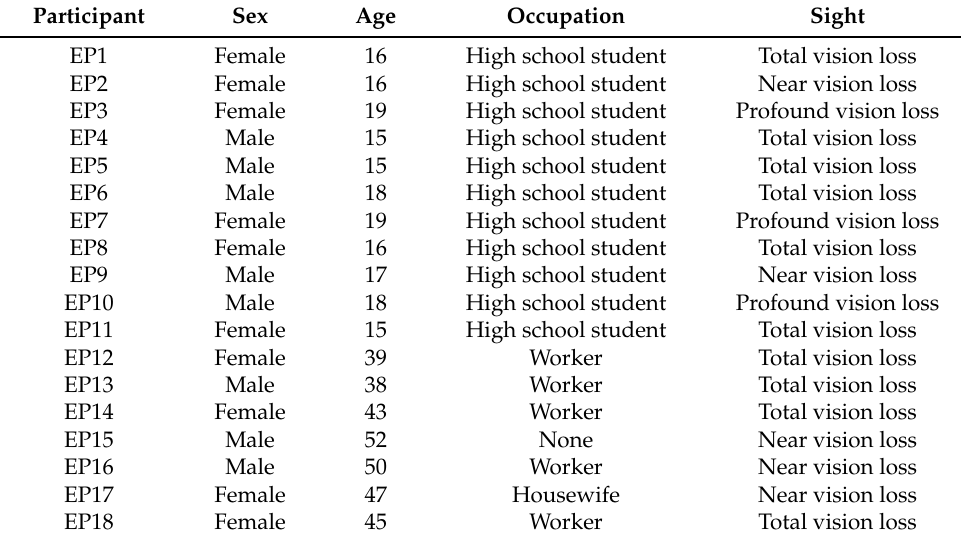
Table 3. Characteristics of participants in our Standard Usability Scale evaluation study.